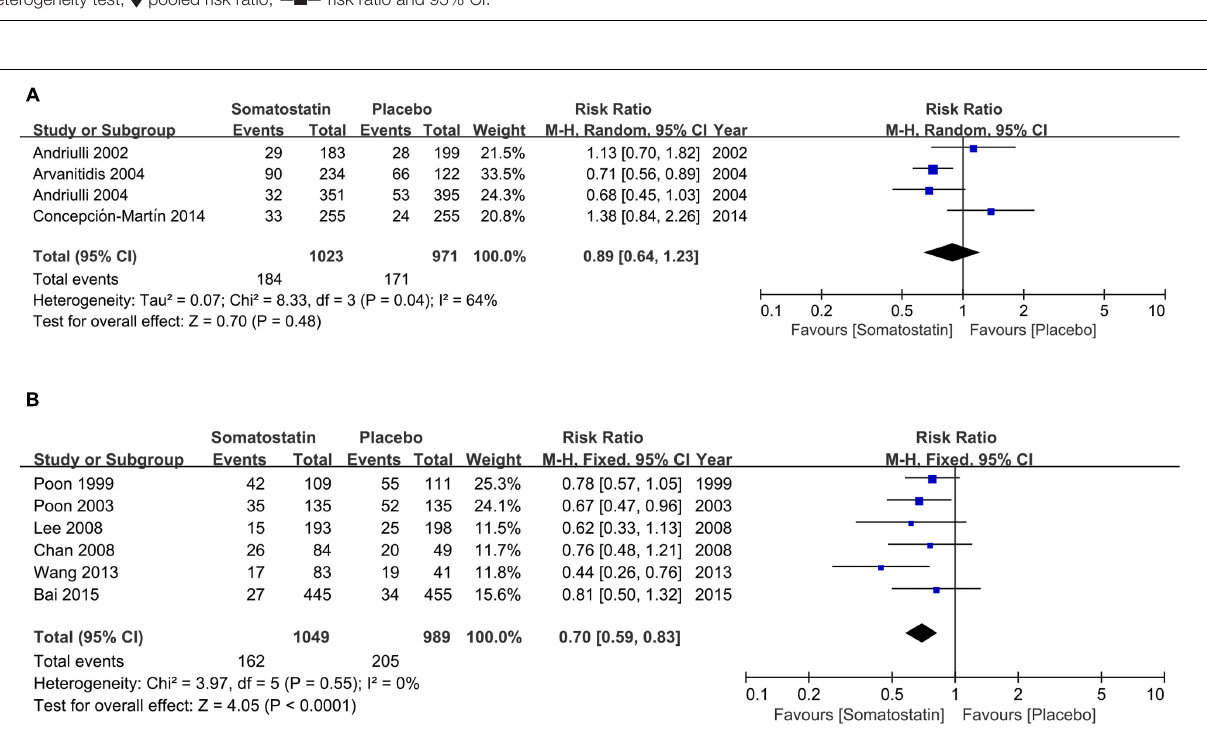
FIGURE 5 | Forest plot of RR of ERCP-induced hyperamylasemia in Europe (A) and Asia (B) . I 2 and P is the criterion of heterogeneity test, (cid:7) pooled risk ratio, — (cid:4) — risk ratio and 95% CI.